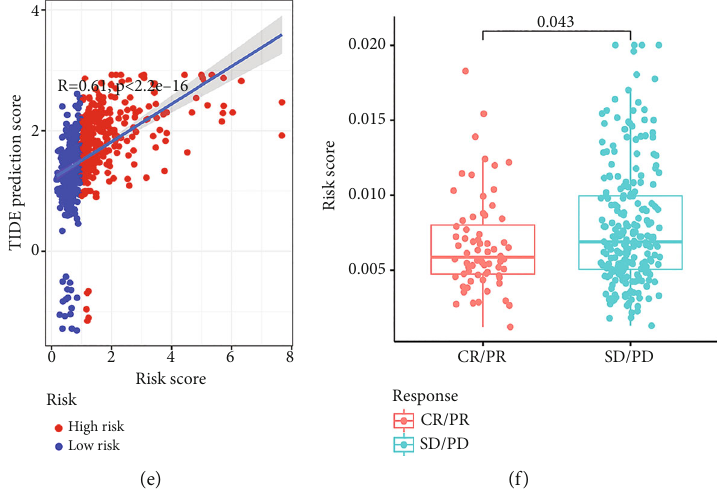
Figure 7: Predicting immunotherapy response by using the risk signature. (a) Di ff erences in the enrichment of immune-related pathways were determined by using ssGSEA ( ∗∗ P < 0 : 01 and ∗∗∗ P < 0 : 001 ). (b) Expression level di ff erence of immune checkpoint genes between the low-risk group and the high-risk group ( ∗ P < 0 : 05 , ∗∗ P < 0 : 01 , and ∗∗∗ P < 0 : 001 ). (c) Expression di ff erence of HLA-related genes between the low-risk group and the high-risk group ( ∗ P < 0 : 05 , ∗∗ P < 0 : 01 , and ∗∗∗ P < 0 : 001 ). (d) TIDE predicting score was acquired to predict immunotherapy response of GC patients. (e) Correlation between TIDE predicting score and risk score. (f) External validation set (IMvigor210) was used to determine the function of the signature in predicting patients ’ immunotherapy